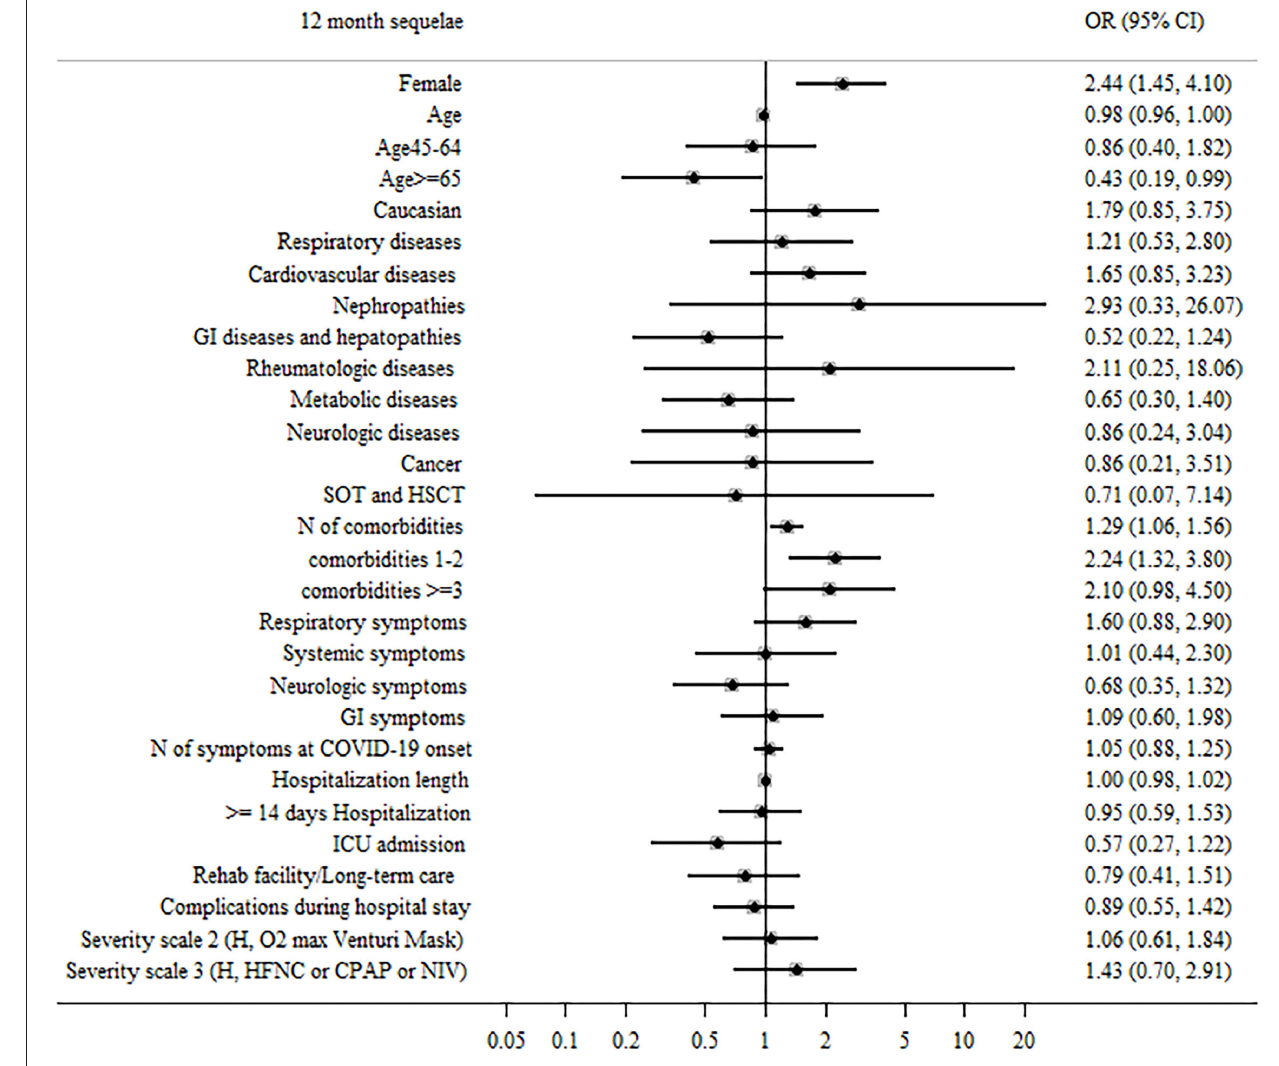
Frontiers in Medicine |